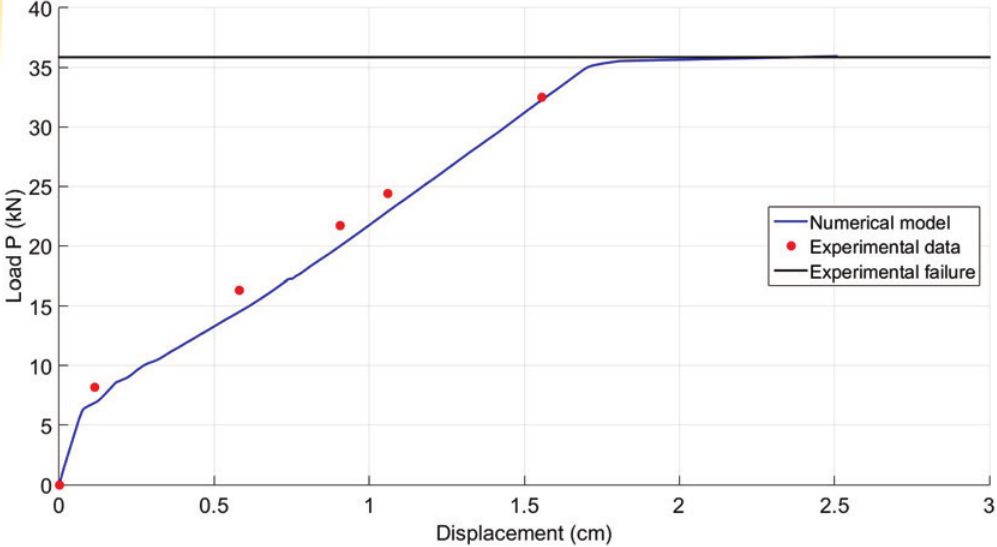
Figure 4.3 Load-displacement plot for the specimen RC-075-1